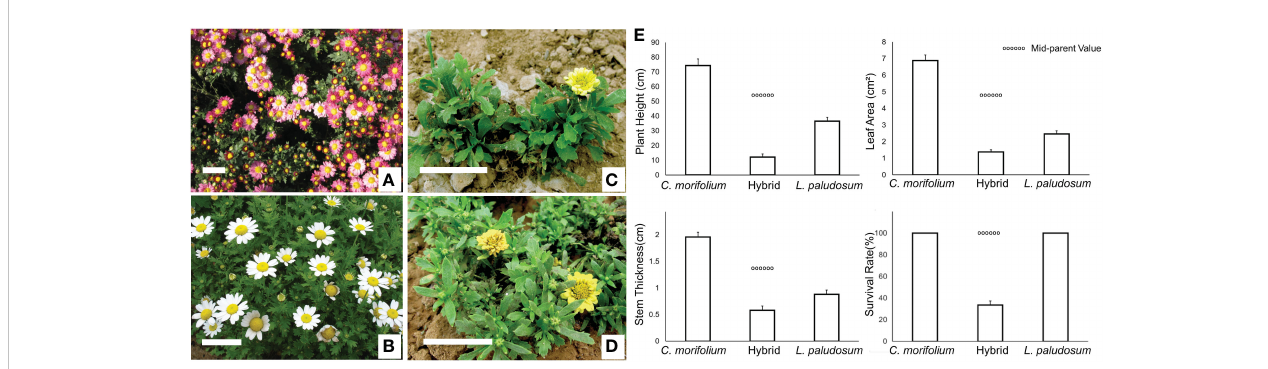
FIGURE 1 Abnormal spring fl owering phenomenon and hybrid disadvantage of ( C ) morifolium × L. paludosum. Florescence state of ( C ) morifolium (A) , L. paludosum (B) and ( C ) morifolium × L. paludosum bloomed from April to May (C) and late October to early November (D) under natural conditions without any treatment. Plant height and leaf area, weak stem thickness, and survival rate of hybrids (E) . Values are mean ± SD. The dotted line denotes the mid-parent value.